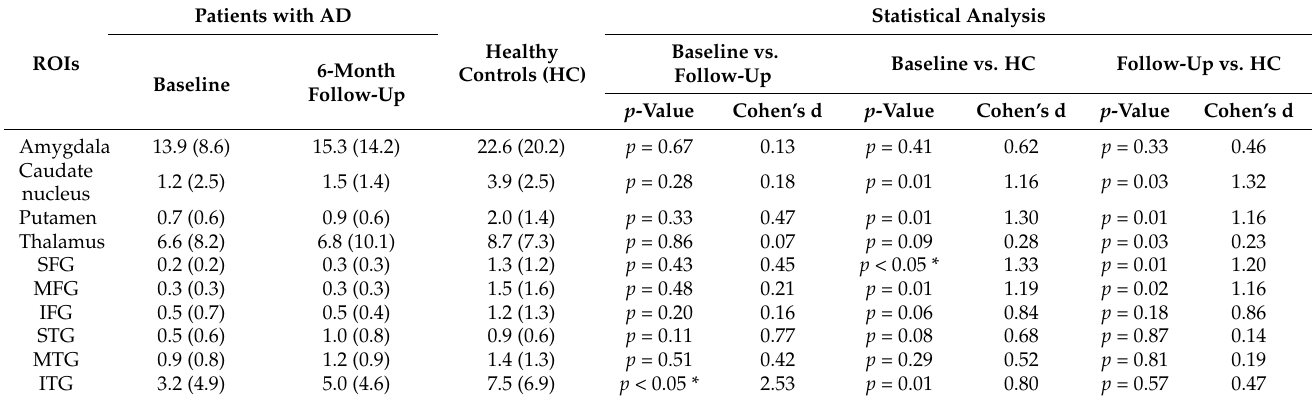
Table 2. The functional connectivity findings using the hippocampus as a seed region in the patients with early AD (baseline and 6-month follow-up) and the healthy controls.